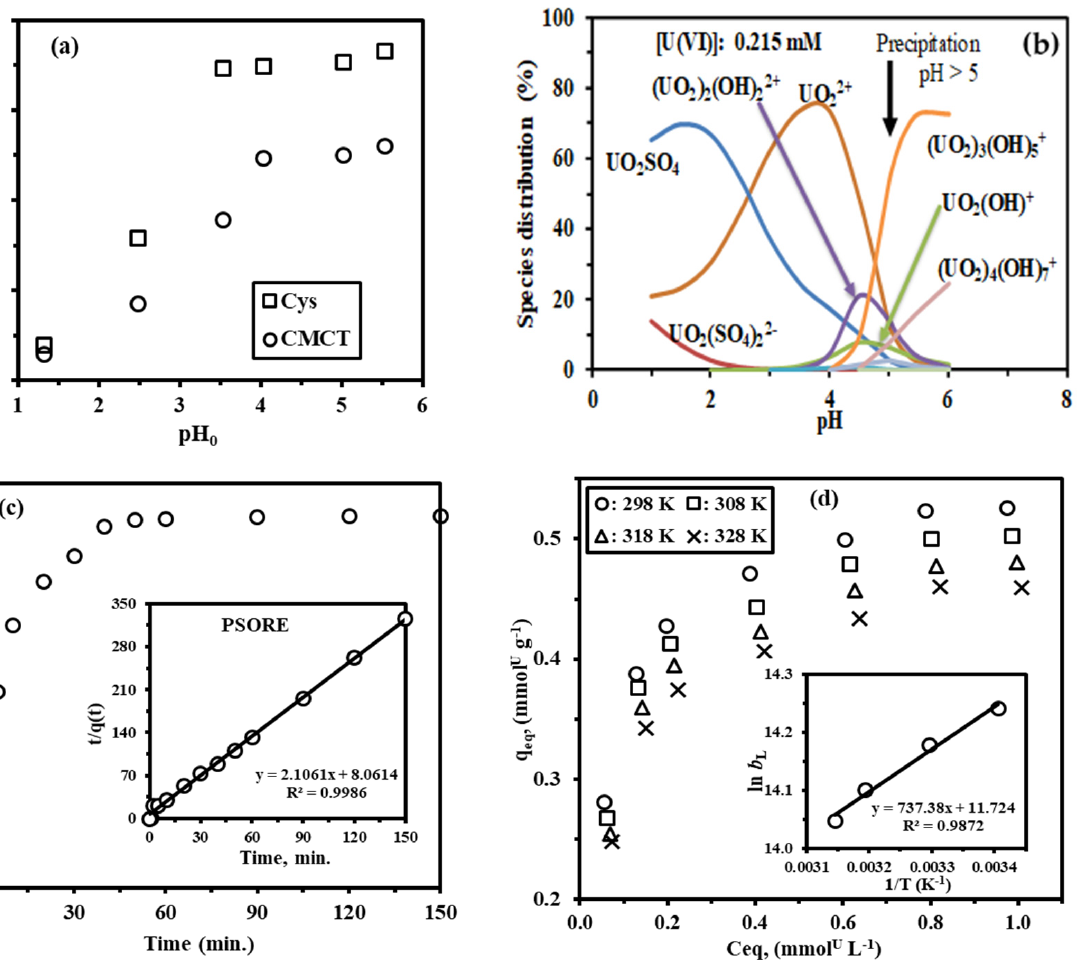
Figure 5. ( a ) The effect of pH on UO 22+ sorption (C 0 : 0.215 mmol U/L, pH 0 : 1.3–5.5, SD: 0.5 g/L, T: 298 K, Time: 180 min, 200 rpm), ( b ) uranyl speciation (sulfuric acid solution) as a function of pH, calculated by using a Visual–Minted program, ( c ) uptake kinetics and PSORE model (C 0 : 0.43 mmol U/L, pH 0 : 4.0, SD: 0.5 g/L, T: 298 K, Time: 0.0–150 min, 200 rpm), and ( d ) sorption isotherms and thermodynamics: Van ’t Hoff plots of ln b L vs. 1/T (C 0 : 0.21–1.26 mmol U/L, pH 0 : 4.0, SD: 0.5 g/L, T: 298–323 K, Time: 60 min, 200 rpm).